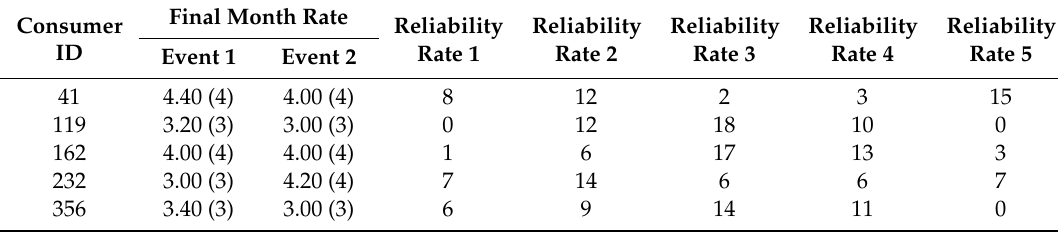
Table 9. Final Reliability Rate from selected consumers when using Method